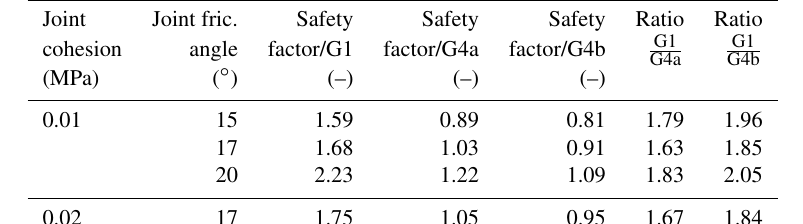
Table 5. Safety factor obtained for a cohesion of 0.01 and 0.02MPa for different friction angles (G1 is dry and non-seismic; G4 is seismic and saturated). Scenarios involving groundwater and seismic shaking considered a complete saturation of the sliding layers (additional GWT5 scenario) and a wavelet of 25s shaking time. G4a and G4b correspond to partial and complete saturation.